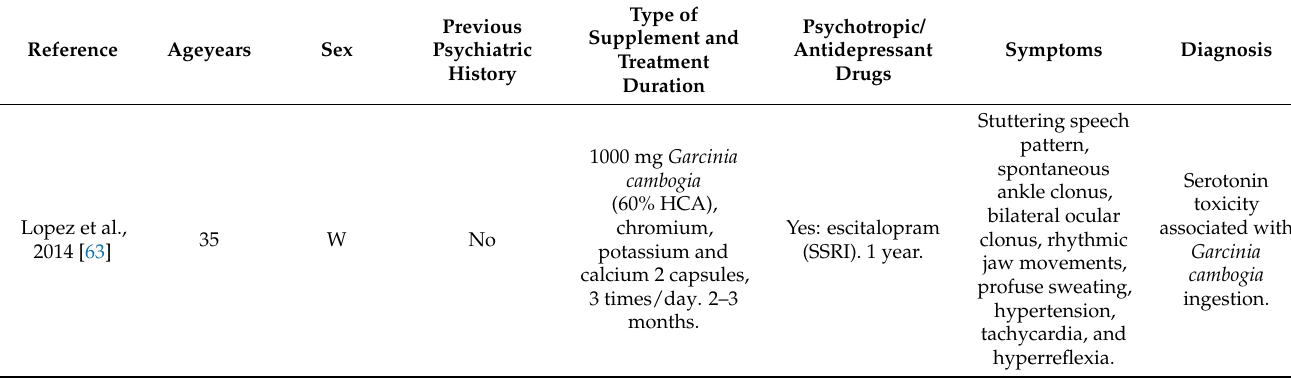
Table 3. Cases of mania and serotonin toxicity associated with the intake of Garcinia cambogia supplements in humans.